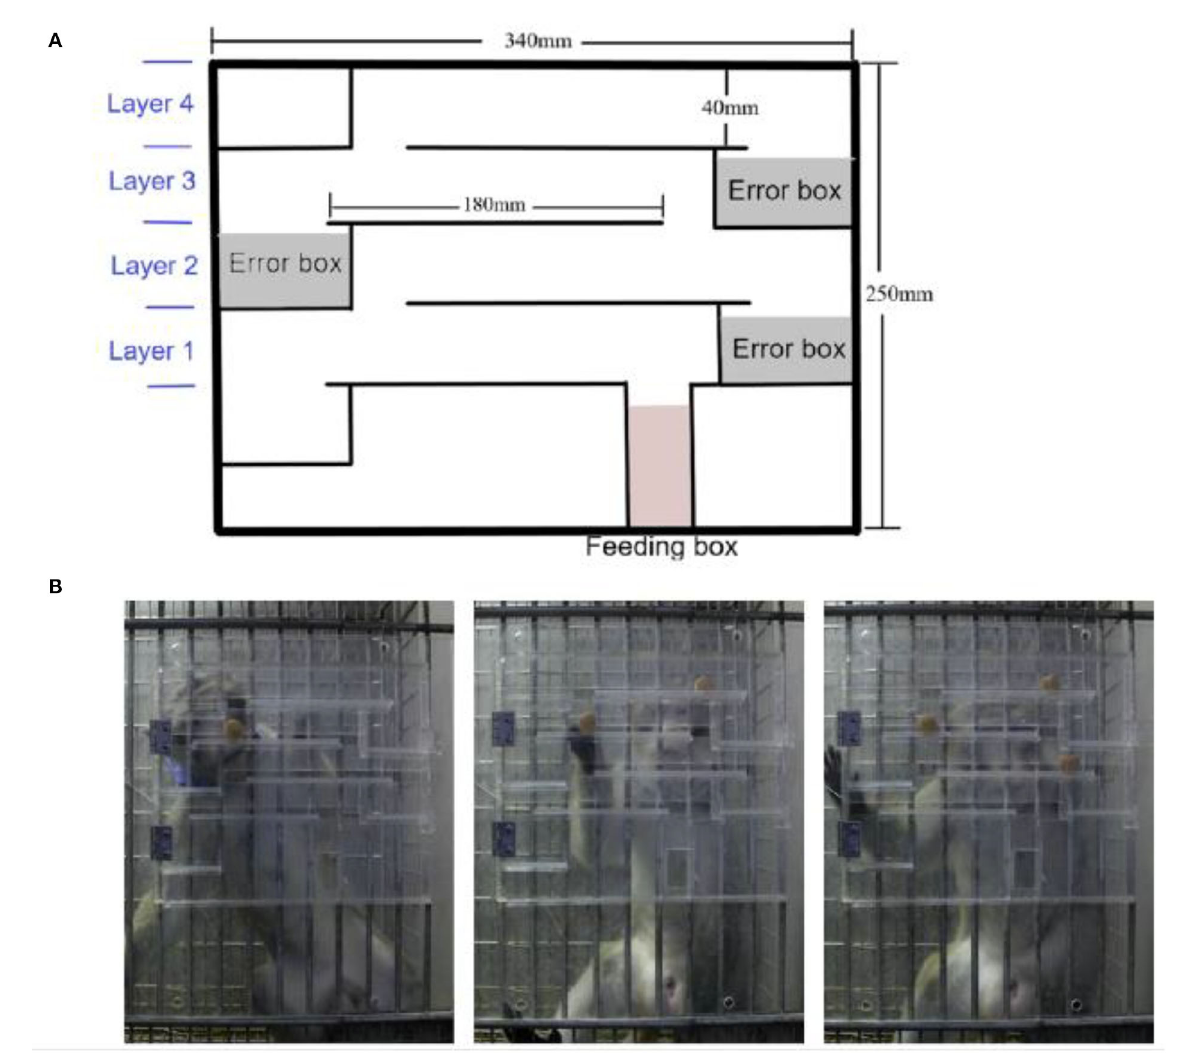
FIGURE1 Application of the modified finger maze test. (A) Schematic diagram of the finger maze apparatus. (B) Different numbers of rewards were placed, one on each